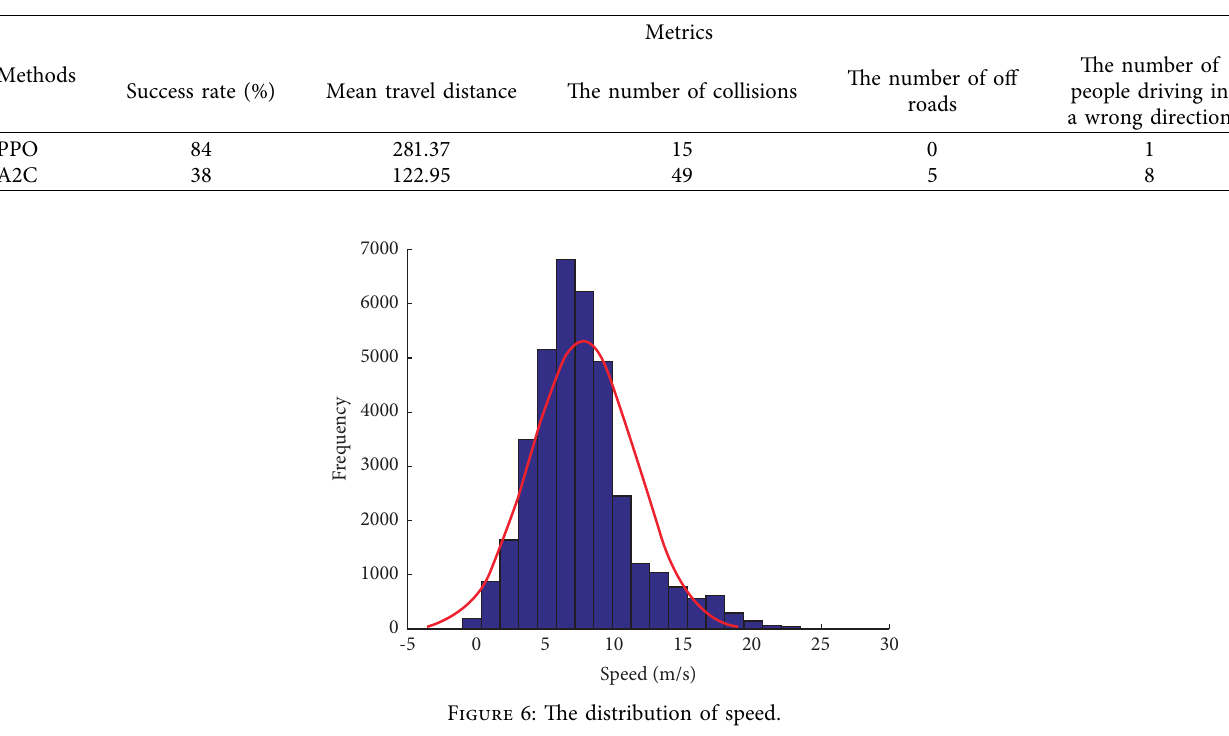
Figure 5: Te change of the mean travel Table 3: Te test results.